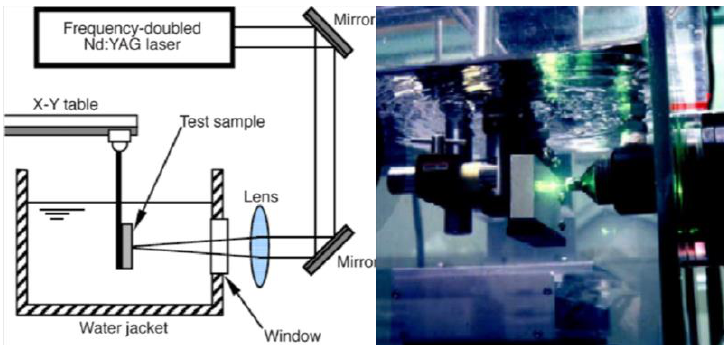
Figure 3. Experimental setup of the LSP process for underwater operation.